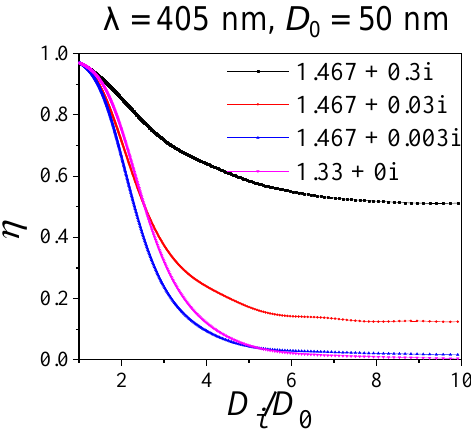
Figure 8. The changes in absorption proportion η with coating thickness ( D i / D 0 ) for various refractive indices of coating material.